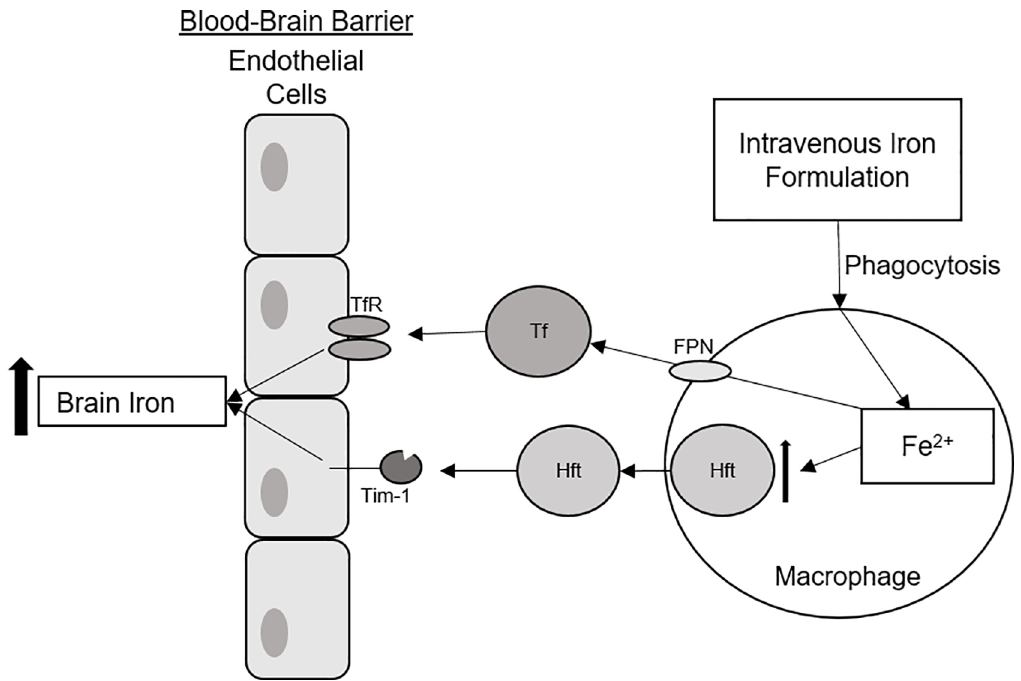
Fig 3. Schematic representation of hypothesized route of IV iron compound after administration. After the IV iron formulations are administered, they are may be initially picked up by macrophages. The macrophages proceed to metabolize the IV iron formulations, storing the excess iron in H-ferritin (Hft). Additionally, free iron may be exported from the macrophage via ferroportin (FPN) where it may be picked up by circulating apo-transferrin or ferritin. Transferrin (Tf) or Hft can bind to transferrin receptor (TfR) or the T-cell immunoglobulin and mucin domain 1 (Tim-1) receptor [42], and then provide iron across the BBB as demonstrated in this